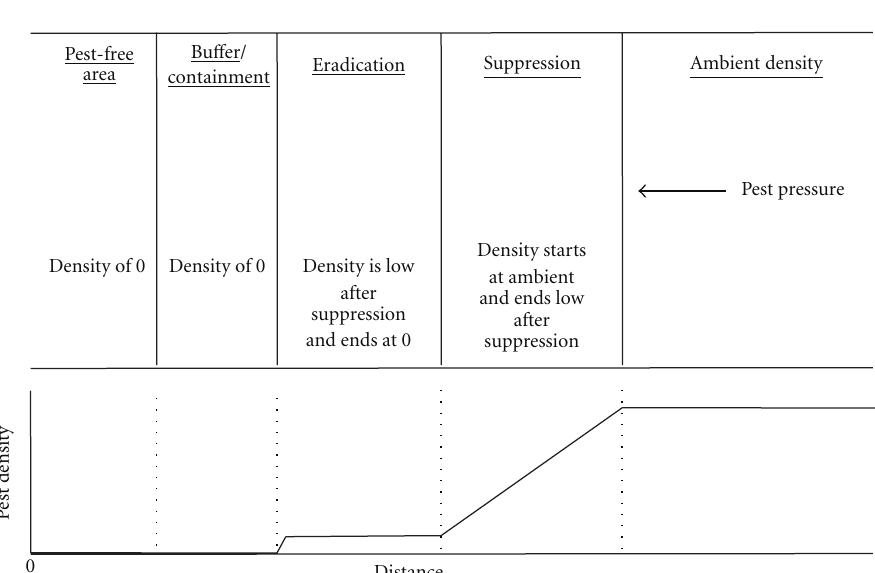
Figure 1: Schematic diagram of the expected changes in pest density from an infested area (high pest pressure), through the bu ff er zone ( B ), into the core area ( A ) in the case of an eradication strategy. In the rolling-carpet approach, declines in pest density represent declines over time, although the form of the slope is